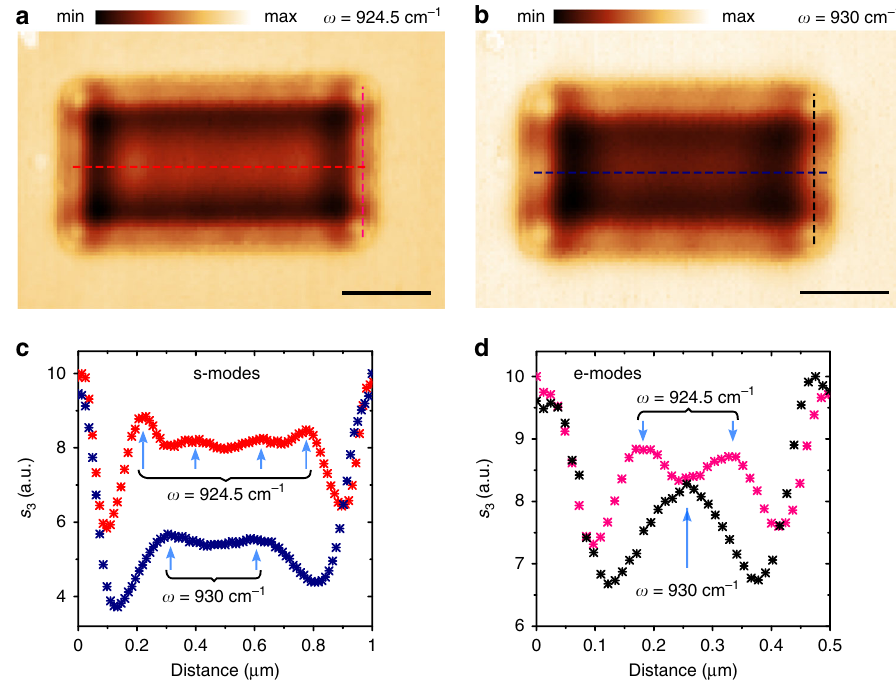
Fig. 4 Tuning near- fi eld patterns on germanium resonator by changing the excitation frequency. a , b s-SNOM images recorded at for 1000 × 500 nm resonator (oxide thickness h = 3.7 nm) at ω ¼ 924.5 cm − 1 and ω ¼ 930 cm − 1 correspondingly. c Normalized near- fi eld cross-sections along horizontal dashed red and blue lines in images a and b highlighting sheet modes. d Normalized near- fi eld cross-sections along vertical dashed pink and black lines in images a and b highlighting edge modes. Scale bars are 300